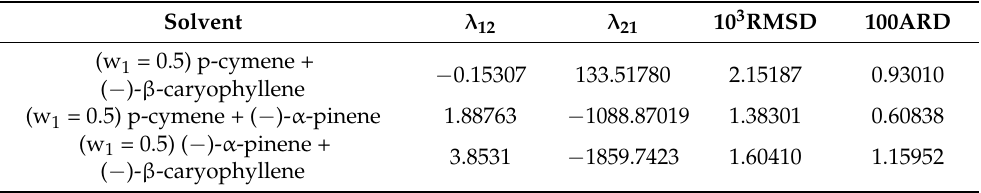
Table 10. Regression results and model parameters of the modified Wilson–van’t Hoff model of dehydroabietic acid in